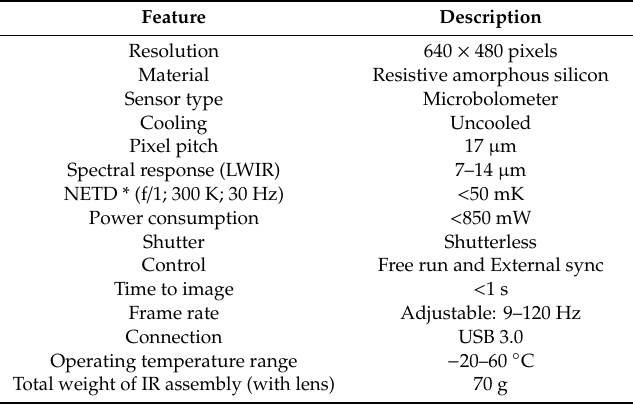
Table 1. Specifications of the infrared thermography (IRT) sensor.